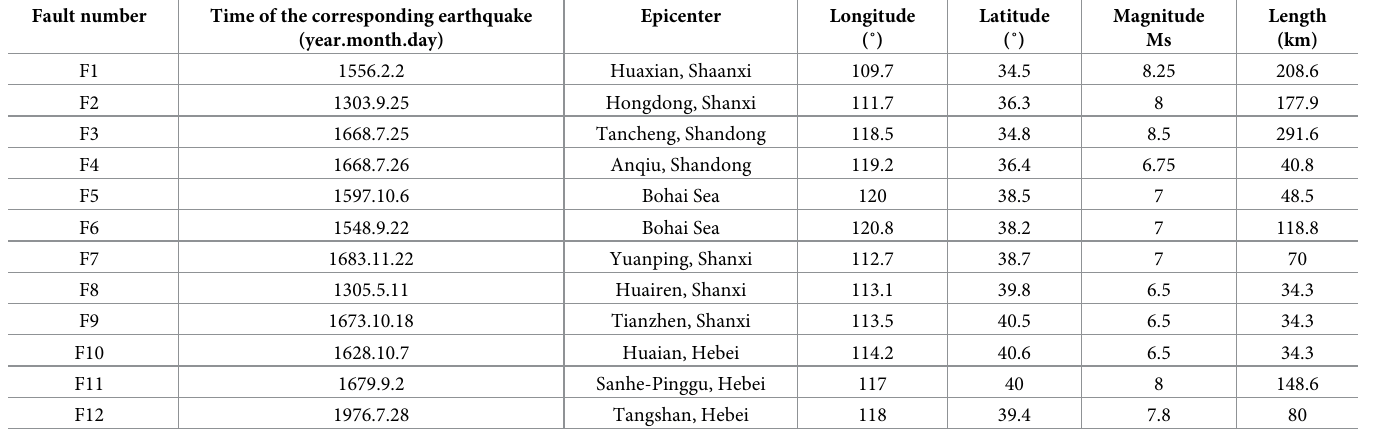
Boundary conditions were applied based on GPS data and the inverse method[23, 43], as fol- lows: the surface of the model was free; the bottom of the model was horizontally and vertically Table 3. Main fault details in the 3D